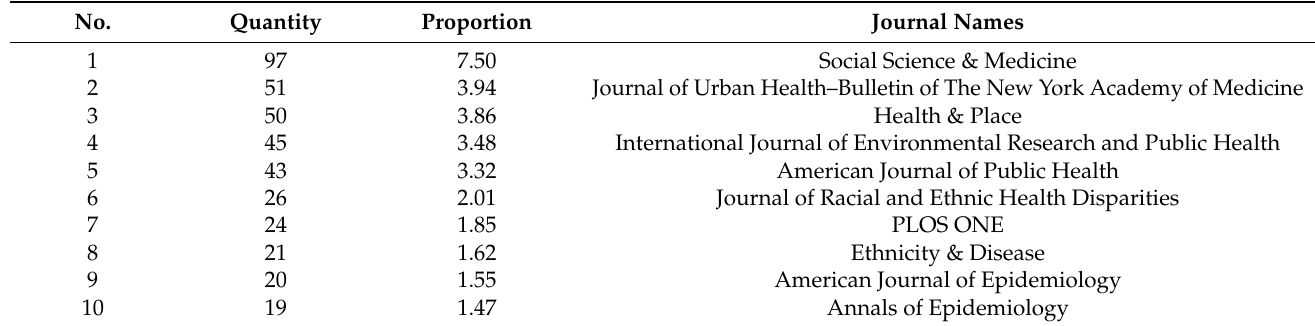
Table 1. Top 10 journals ranked by the number of publications in RSH